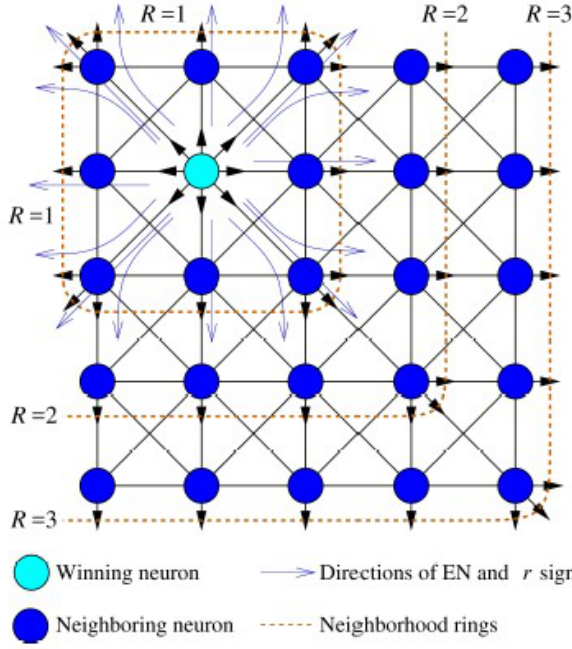
Figure 3. A simplified structure of the proposed fully parallel and asynchronous neighborhood mechanism. An example case of the map topology with eight neighbors per